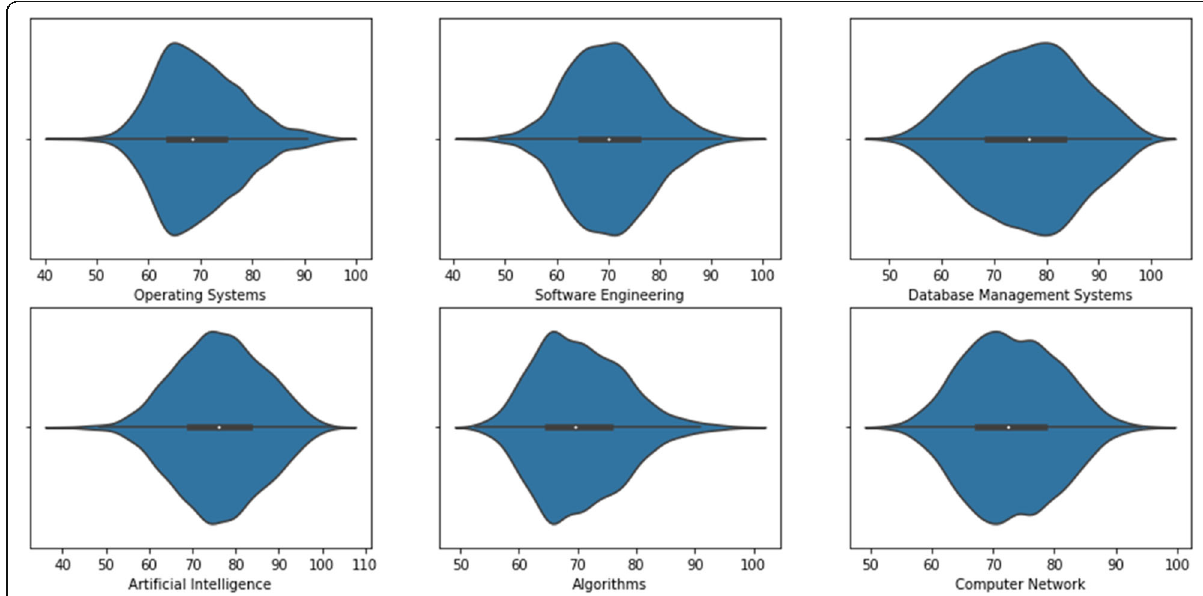
Fig. 6 Violin plot representing the distribution of marks of the main